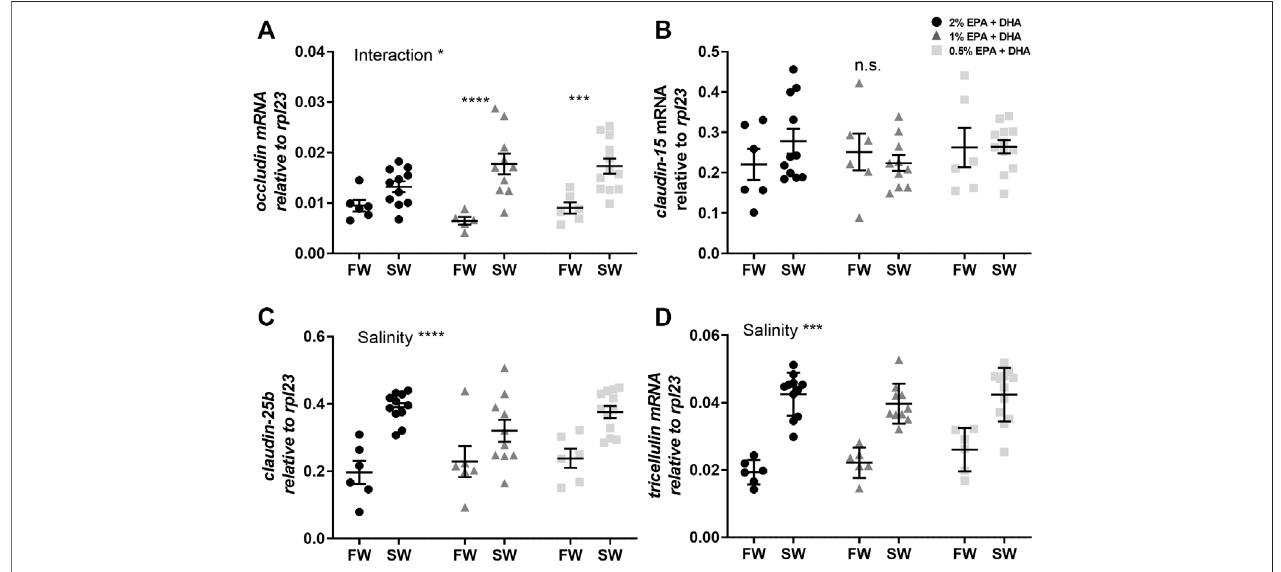
FIGURE 4 | Transcript levels of (A) occludin , (B) claudin-15 , (C) claudin-25b and (D) tricellulin in the distal intestine of freshwater (FW) smolts and seawater (SW) acclimated Atlantic salmon smolts fed different levels of omega-3. Statistics: two-way ANOVA where signi fi cant interaction was analysed using Sidak ’ s multiple comparisons test. Signi fi cant effects are reported as * p < 0.05 and *** p < 0.001. Data are presented as individual values with the horizontal line representing the mean and the vertical lines SEM.